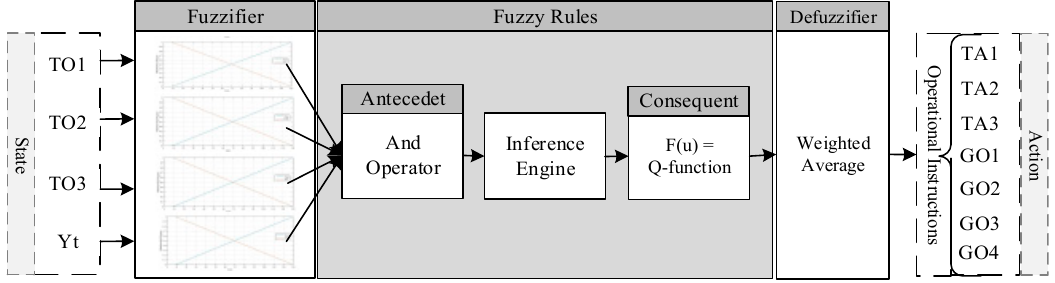
Figure 4. The defined Takagi–Sogeno–Kang (TSK) fuzzy system associated with block 1.